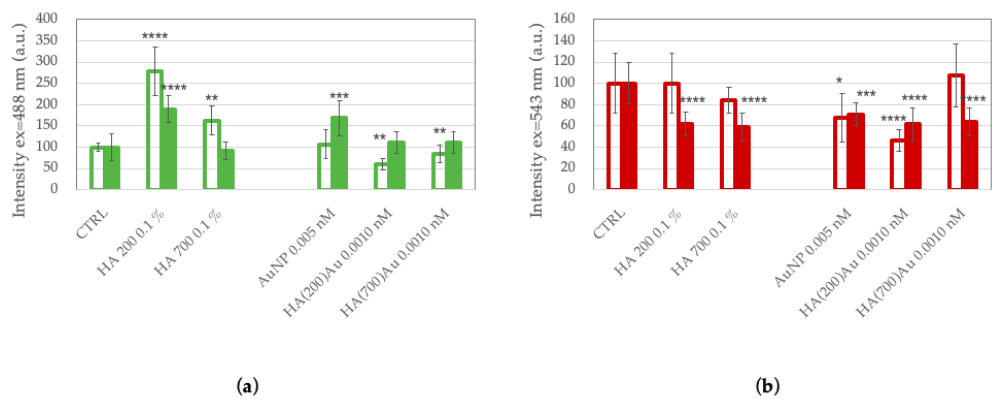
Figure 10. LSM merged confocal micrographs of neuroblastoma (SH-SY5Y, upper panels) and prostate cancer (PC-3, lower panels) cells: in blue, the nuclear staining with Hoechst (λ ex/em = 405/425– 450 nm); in green, the cytoskeleton actin staining with Actin Green (λ ex/em = 488/500–530 nm); in red, the lysosomal staining with Lysotracker Red (λ ex/em = 543/550–600 nm). Cellular treatments were carried out for 90 min with ( a ) AuNP (0.005 nM = 5.5 × 10 2 NP/mL); ( b ) HA(200)Au (0.0010 nM= 7.2 NP/mL, 0.1% w / v HA); ( c ) HA(700)Au (0.0011 nM = 2.5 × 10 1 NP/mL, 0.1% w / v HA). Scale bar = 20 µm.